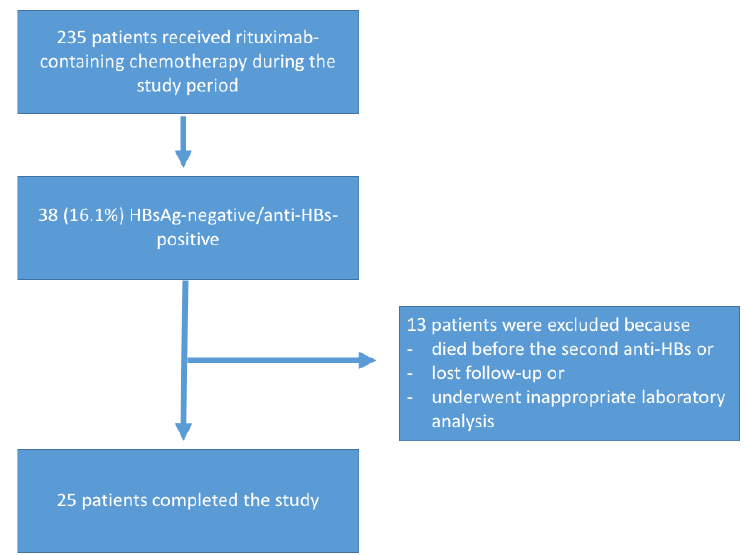
Figure 1. Flowchart of subjects who participated in the anti-HBs kinetics group.